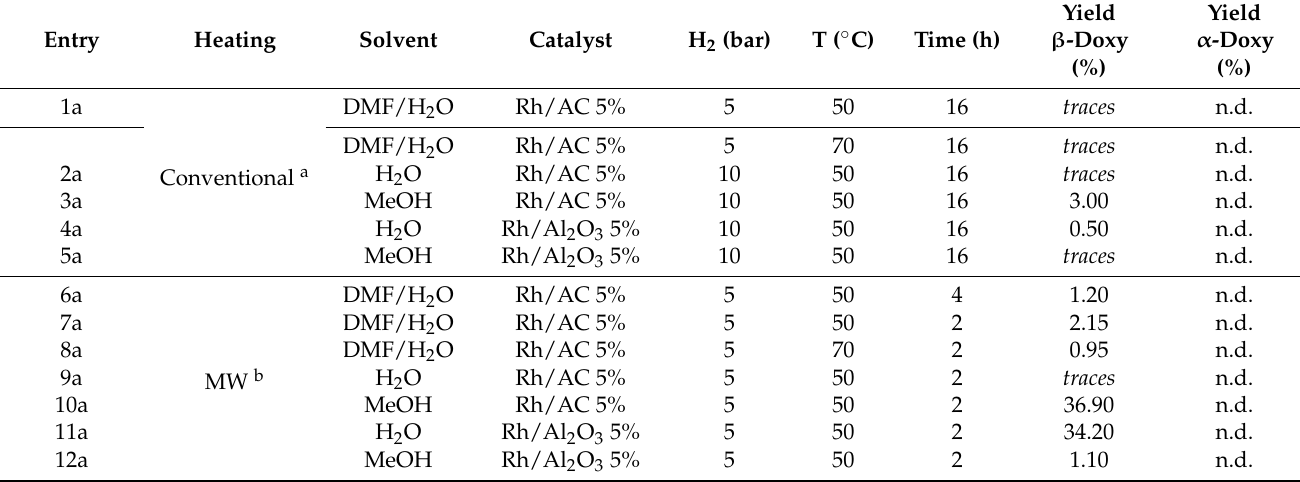
Table 1. Doxycycline synthesis under conventional and MW-assisted